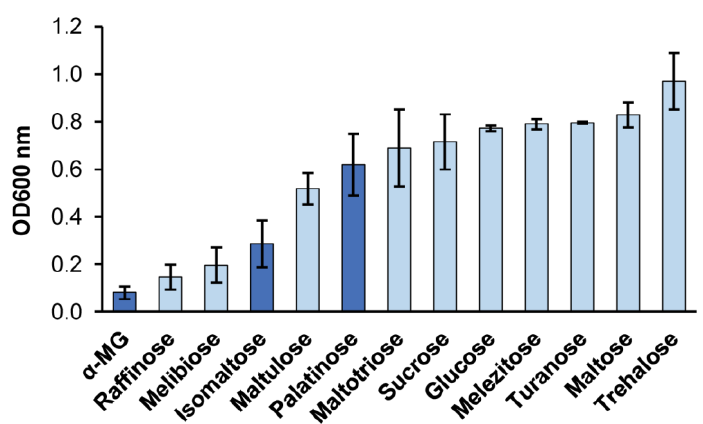
Figure 3. Growth of B. adeninivorans on sugars (supplemented at 2 g/L) evaluated by an optical density (OD) of the culture at 600 nm achieved by 24-h cultivation on a microplate at 37 °C. Isomaltose and isomaltose-like sugars are indicated by dark blue bars. Error bars are representing standard deviations (SD) of two independent experiments with two replicates.